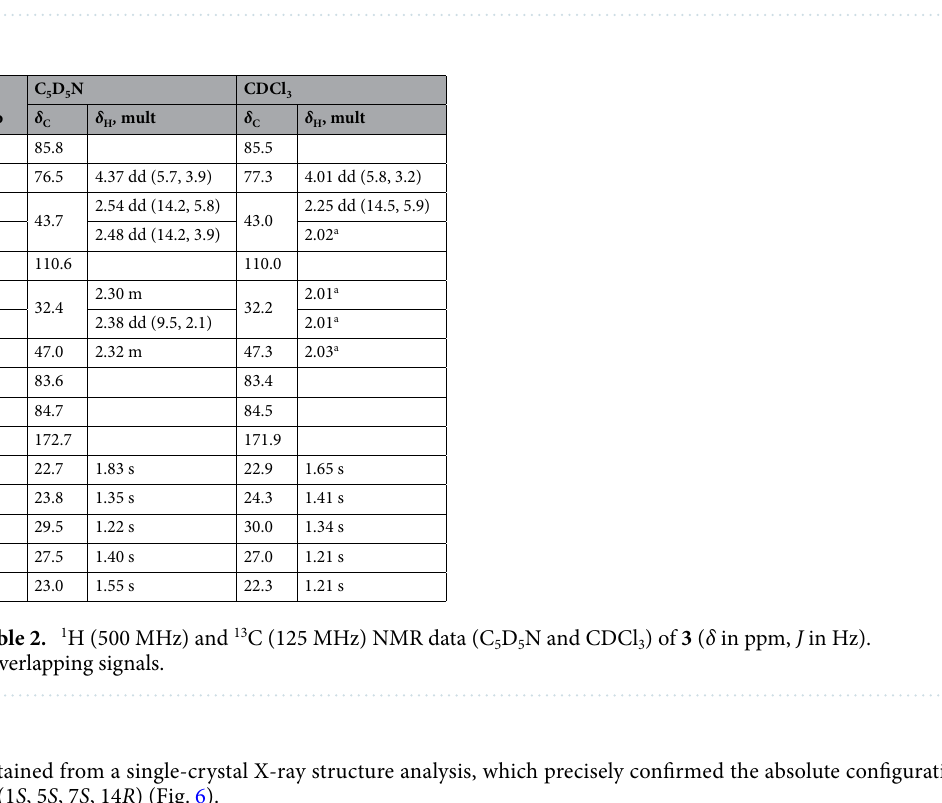
Figure 7. Putative biosynthesic pathway to 2 .